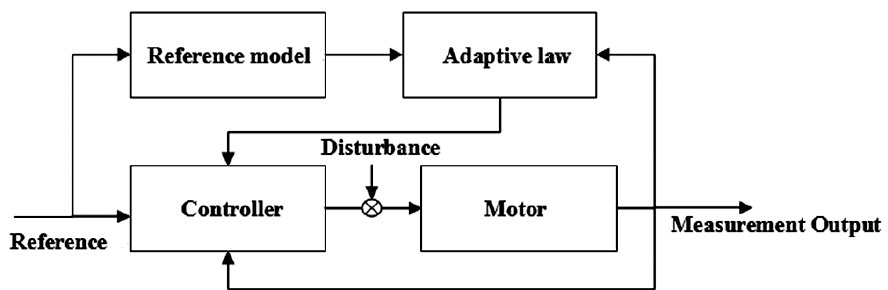
Figure 1. MRAC control sketch of the motor.